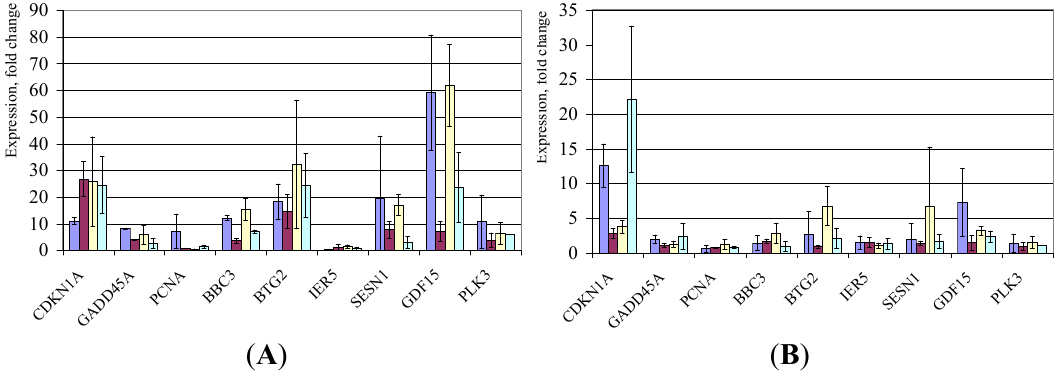
Figure 5. Stress-responsive gene expression changes in hESCs after HD of IR exposures (1 Gy). Shown are mean relative quantities (±SD) for cell cultures post treatments compared to sham-IR. In blue, H1 hESC line; in maroon, H7; in yellow, H9; and in green, H14. ( A ), gene expression changes 2 h post-IR; ( B ), 16 h post-IR,